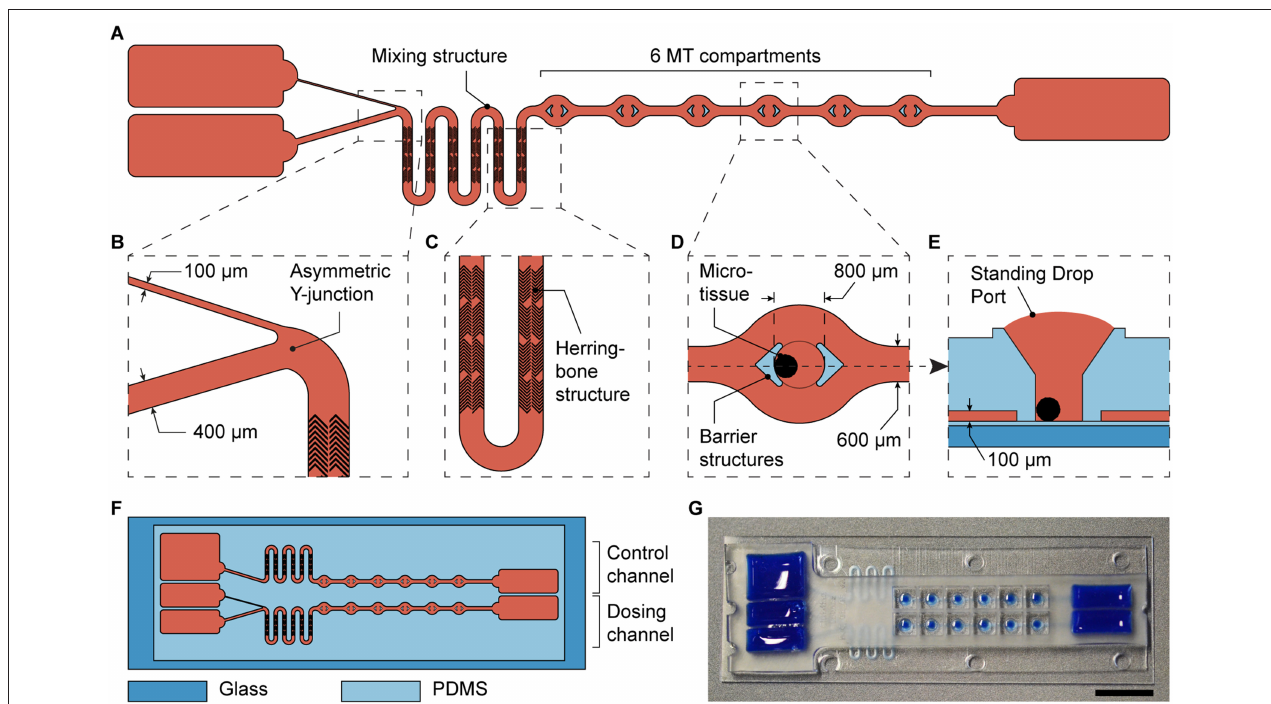
FIGURE 4 | Integration of the asymmetric design into a microfluidic microtissue-culture chip. (A) Microfluidic channel layout with the asymmetric Y-junction, followed by a mixing structure and six microtissue (MT) compartments. Details are shown in (B) the asymmetric Y-junction, (C) the micromixer including herringbone structures in a meander-shaped channel, and (D) the top view of a MT compartment with protective barrier structures and (E) a side view of a MT compartment. (F) Each microfluidic chip has the size of a microscopy slide and includes a dosing channel with a Y-junction, next to a control channel for linear exposure profiles. (G) Photograph of the microfluidic chip the channels and reservoirs of which have been filled with a colored liquid (scale bar: 10 mm).